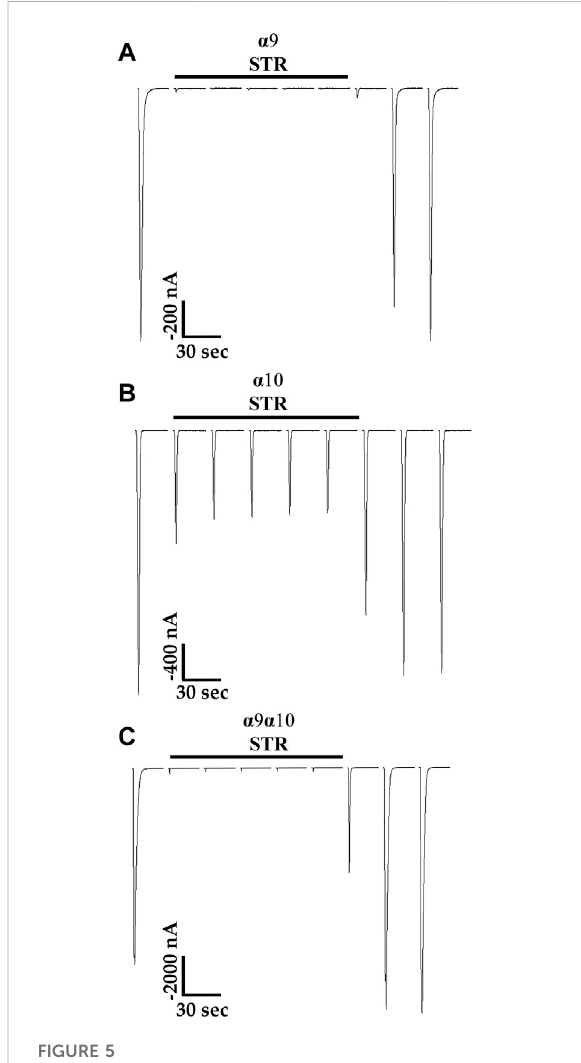
FIGURE 5 Strychnine is an antagonist of human α 9, α 10, and α 9 α 10 nAChRs expressed in X. laevis oocytes. Oocytes were injected with cRNA encoding either human α 9 subunits or α 10 subunits to form homomeric subtypes or with cRNA for α 9 subunits and α 10 subunits together (1:1) to form heteromeric α 9 α 10nAChRs.Oocyteswerethenincubatedfor3 – 4 dayspriorto voltage-clamp electrophysiology. (A) Current traces from an oocyte, preincubated with saline containing 5 mM choline, expressing α 9 nAChRs. The ACh-evoked currents after acute applicationofSTR(20 μ M)were3±3%(n=5)ofcontrolvalues. (B) Current traces from an oocyte, preincubated with STR (20 μ M), expressing α 10 nAChRs; the ACh-evoked currents after acute application of STR (20 μ M) were 52 ± 13% (n = 5) of control values. (C) Current traces from an oocyte, preincubated in saline, injected with cRNA for α 9 and α 10 nAChRs; the ACh-evoked currents after acute application of STR (20 μ M) were 1.0 ± 0.5% (n = 5) of control values. Current traces are shown with the 30 s interpulse intervals reduced to 5 s for brevity, and the horizontal bars above the traces indicate a 5 min perfusion with saline containing STR. The “ ± ” indicates the SD and “ n ” indicates the number of oocytes obtained from three